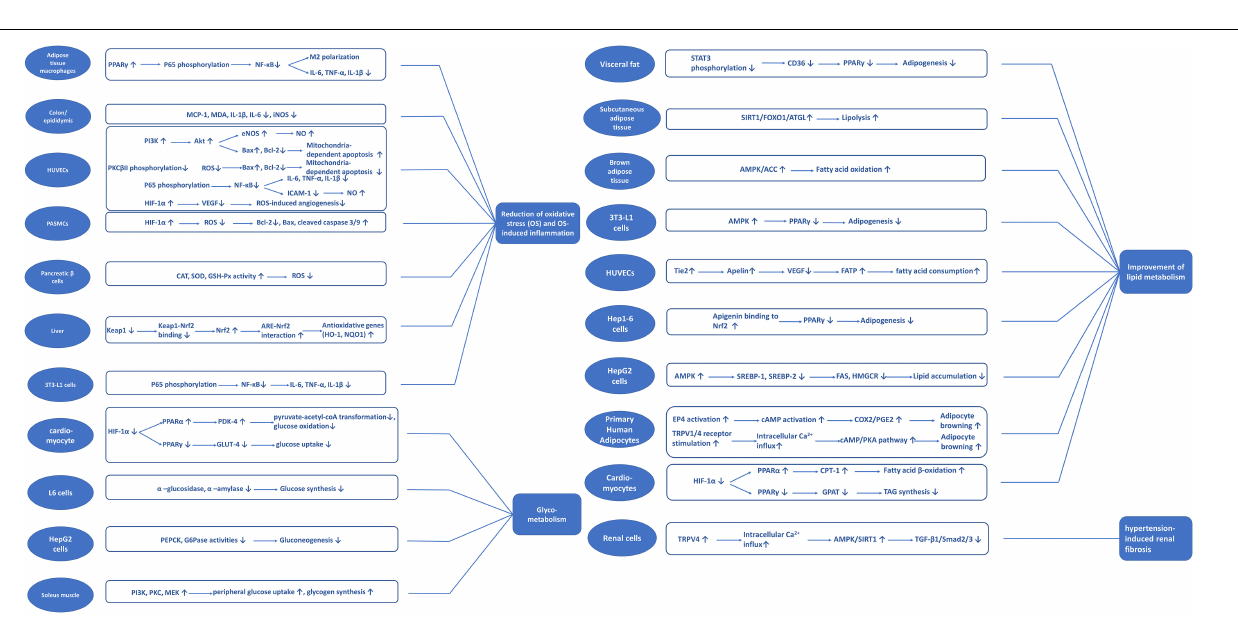
FIGURE 3 | Potential signaling pathways classified with different mechanisms of apigenin on cardiometabolic diseases.